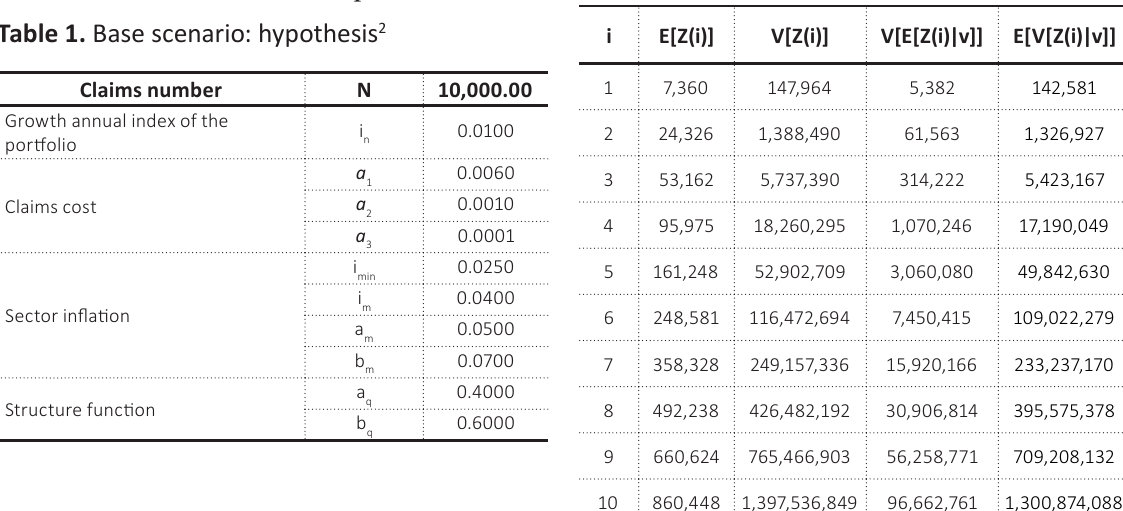
Table 2. Statistics on the current value of